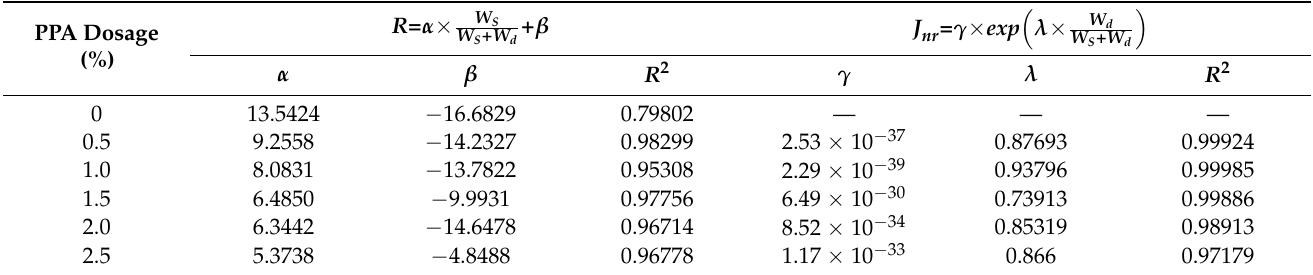
Table 5. Fitting results between deformation parameters and energy Table 5. Fi tt ing results between deformation parameters and energy parameters.